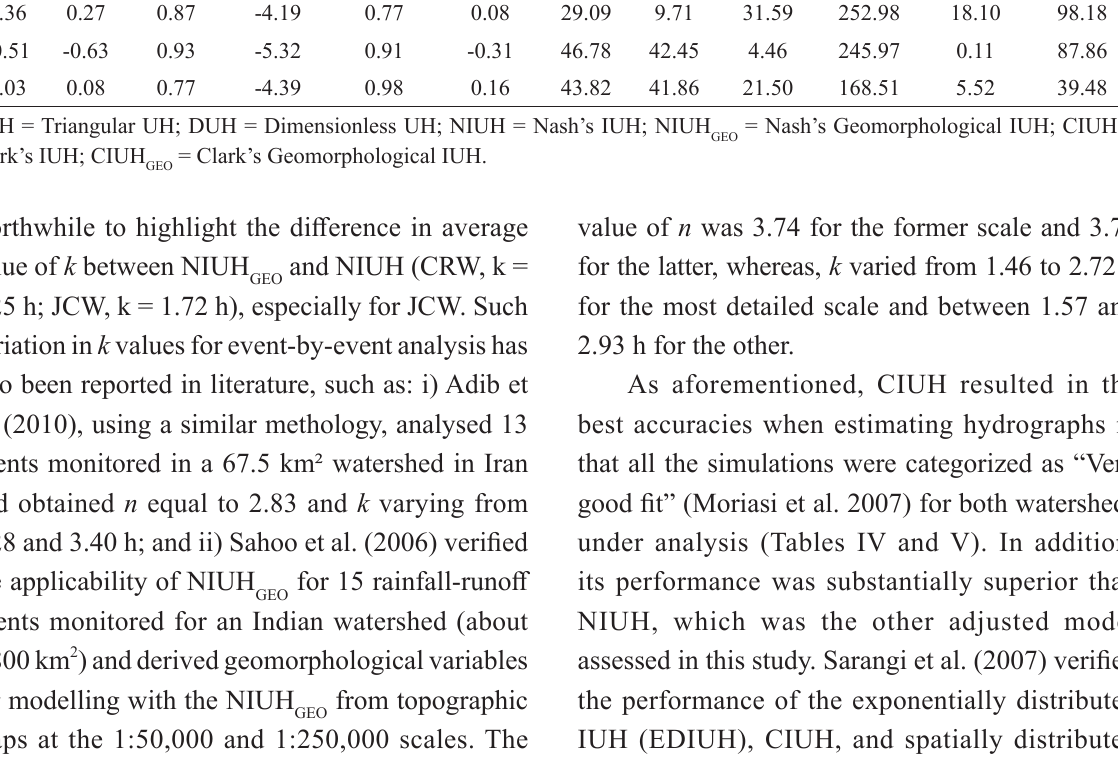
) for each rainfall-runoff event monitored at Qp